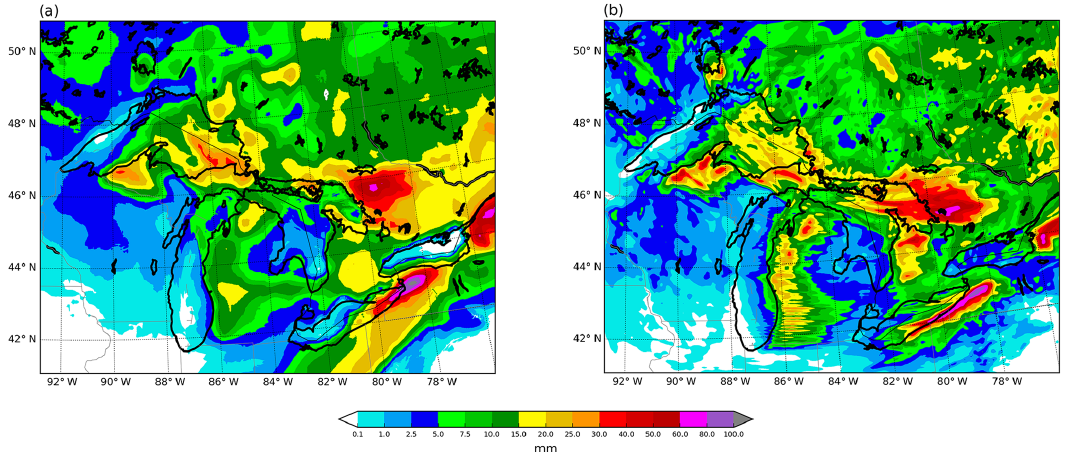
Figure 12. Observed (a) and simulated (b) accumulated snow water equivalent (mm) from 17 November at 06:00UTC to 21 November at 06:00UTC.